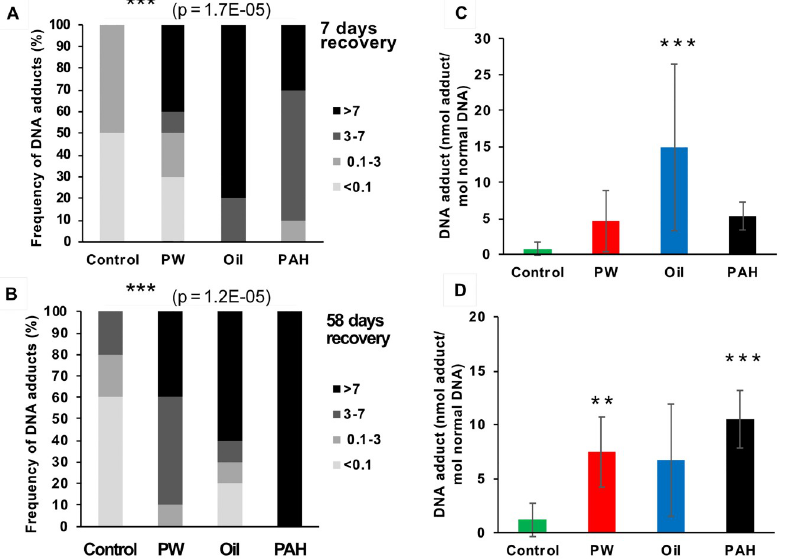
Fig 4. DNA adducts in the liver of fish from the different treatments groups after 7 day recovery (A and C, n = 10), 58 days recovery (B and D, n = 10). A-B are showing the frequency (%) of DNA-adduct divided into four intervals (below detection limit; < 0.1 nmol DNA adduct/mol normal DNA, 0.1–3 nmol DNA adduct/mol normal DNA, 3–7 nmol DNA adduct/mol normal DNA, > 7 nmol DNA adduct/mol normal DNA. Asterisks indicate statistical difference in the relative distribution between the treatment groups (Fisher Exact Contingency Table analysis). P < 0.001 = ��� . C-D are showing the average amount of DNA adduct ( ± SD). Asterisks indicate statistical difference to the control fish (Kruskal-Wallis Test). P < 0.01 = �� , P < 0.001 = ��� .